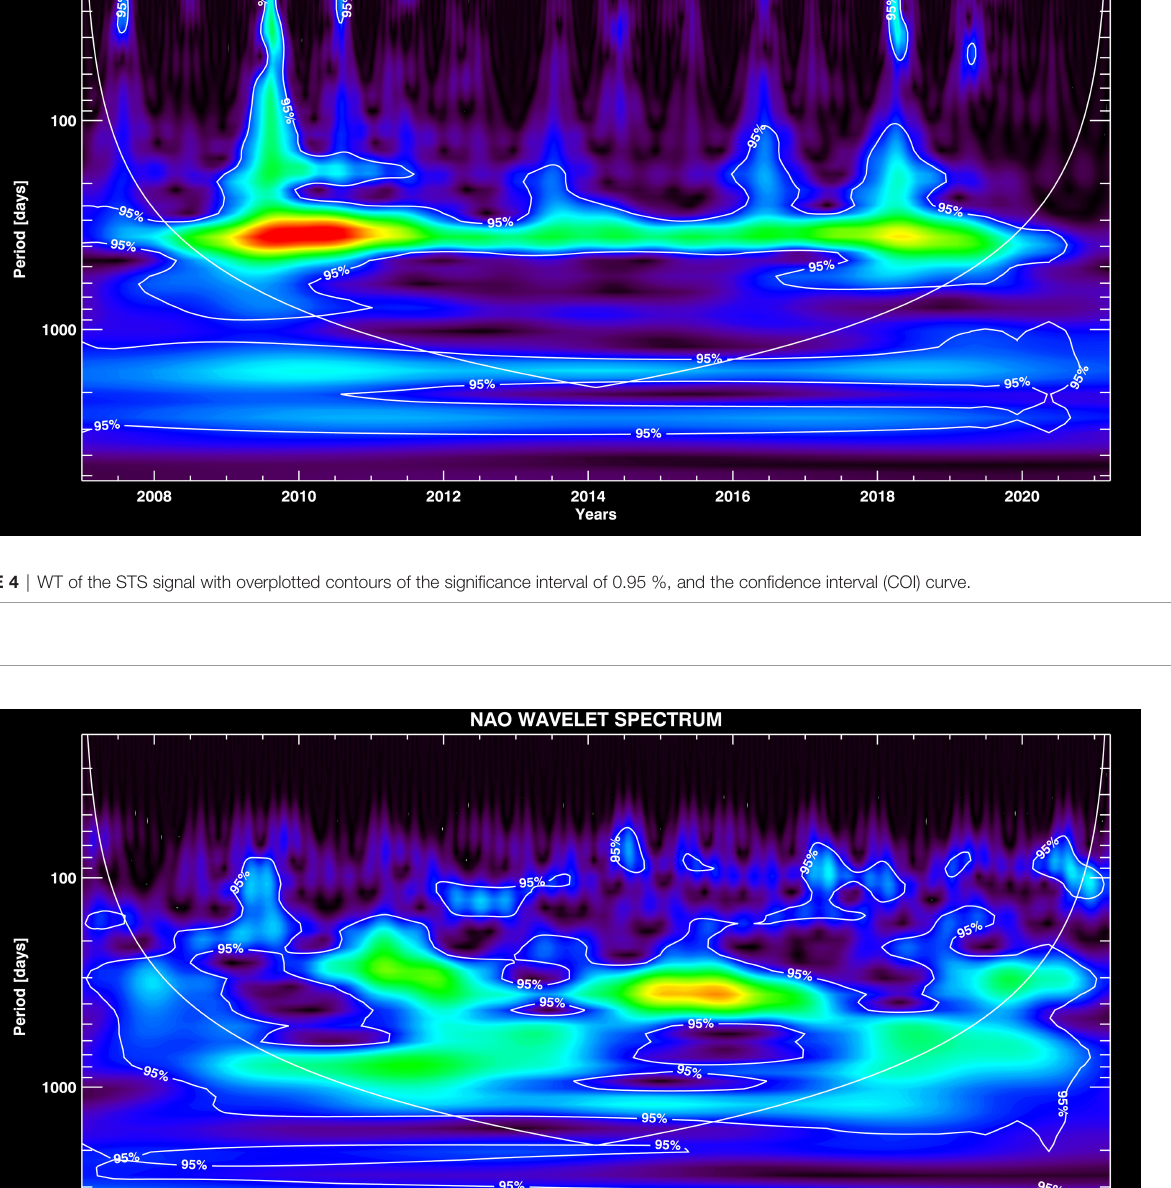
Supplementary Figure 6 respectively. The correlation coef fi cient dependence on the time shift is shown in Supplementary Figure 6A . Without any STS shift, a strong negative linear relationship is observed ( R = - .96, p < .001,